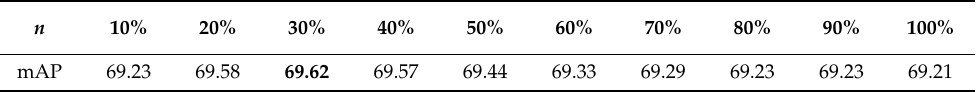
Table 9. The influence of n on retrieval. The maximum mAP value is in bold.